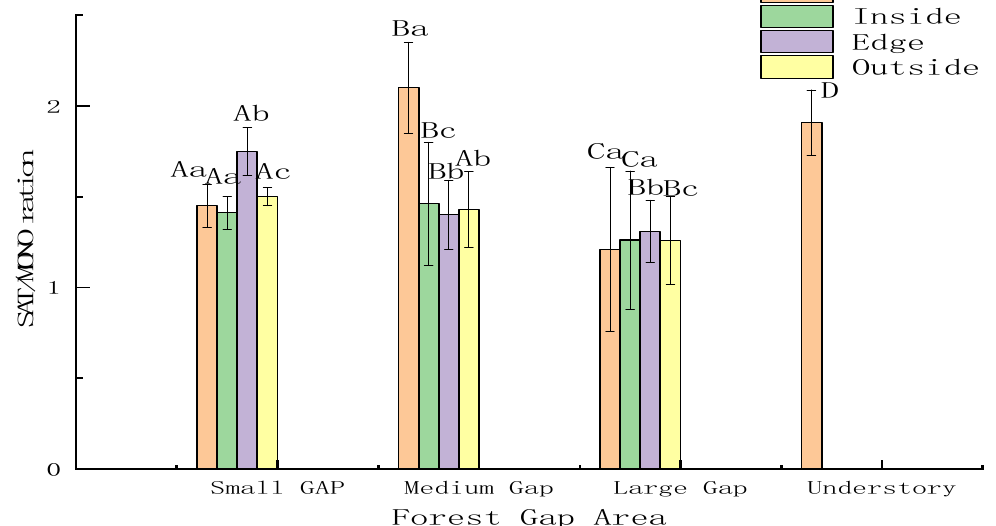
Note: A, B, C, and D indicate differences in the same gap position with different sizes; a, b, c, and d show differences in the different positions within the same gap ( p < 0.05).